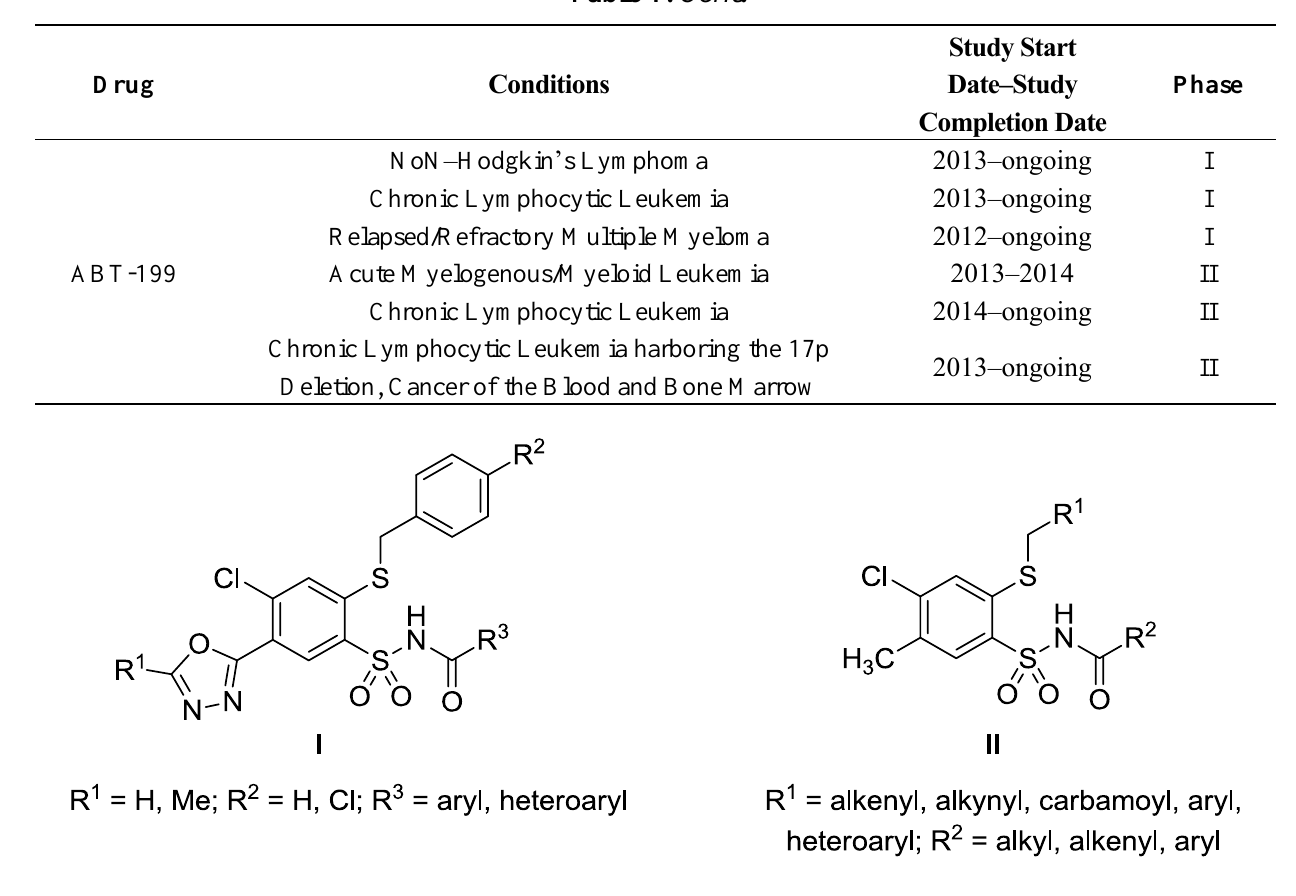
Figure 2. Structures of N -acylsulfonamides I and II